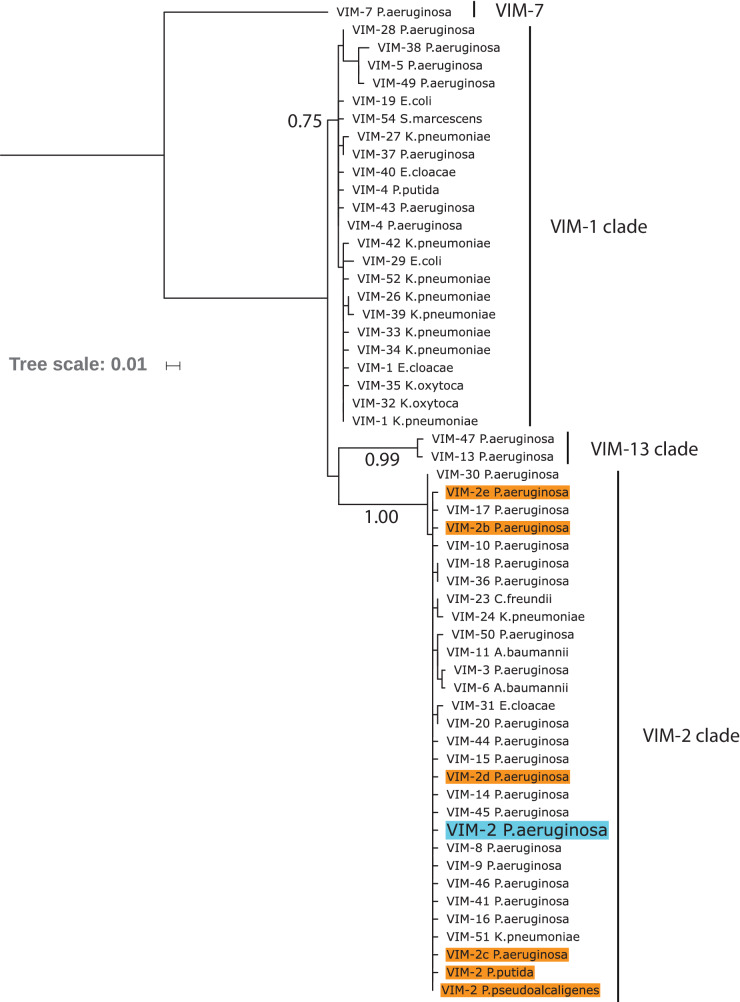
Maximum likelihood phylogenetic tree of wtVIM-2 and 55 VIM-type variants.The leaves in the tree indicate individual VIM-type variants labeled by number and host organism, with the wtVIM-2 sequence highlighted in blue. Other VIM-2 sequences are labeled in orange, and VIM-2 sequences that share the same host as wtVIM-2 have been labeled VIM-2b/c/d/e for disambiguation. The number beneath the branches indicate the normalized bootstrap value of 100 bootstrap replicates, and only bootstrap values above 0.75 are displayed. The major clades are noted by the labels on the right side. The tree was generated using MEGA7. The full list of variants can be found in Supplementary file 2J.